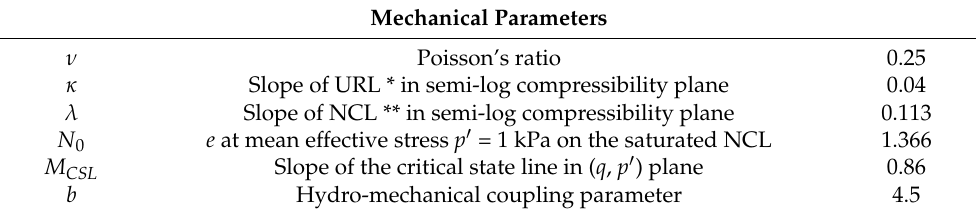
Table 3. Mechanical parameters of the Modified Cam Clay model extended to partial